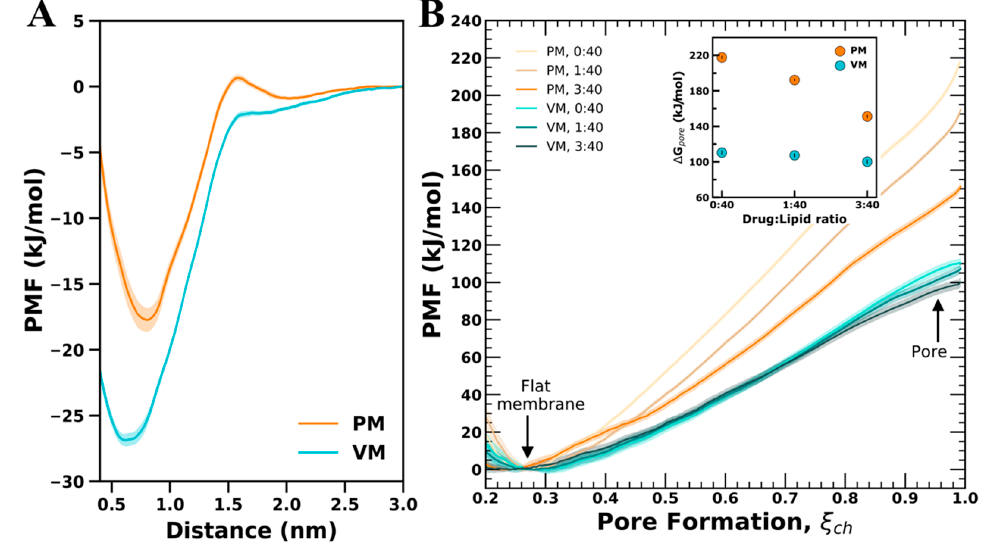
Figure 4. Free-energy of binding and free-energy of pore formation over PM and VM for CHX. ( A ) PMFs showing CHX binding free-energy for VM (cyan shaded) and PM (orange shaded). ( B ) PMFs showing effect of CHX on pore formation, which is dependent on the CHX:Lipid ratio (see legend). The Δ Gpore with respect to CHX:Lipid ratio taken at ξ = 1 is shown in the inset.